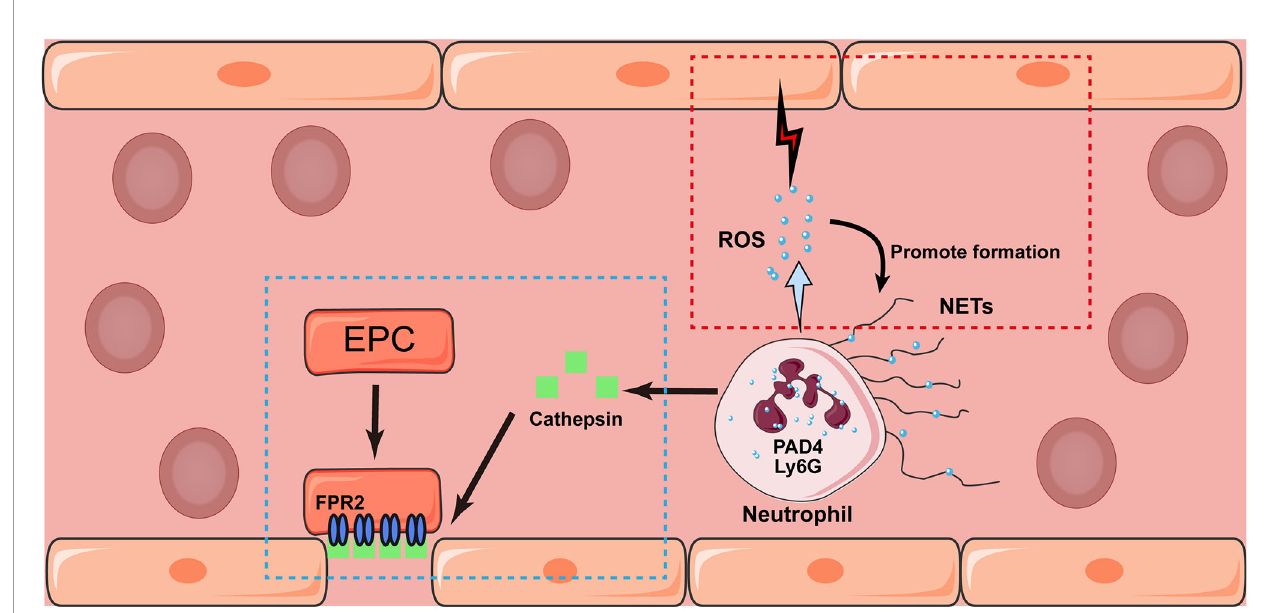
FIGURE 2 | Potential interaction between neutrophil and endothelium after stroke. Neutrophil may exhibit either detrimental (marked in red box) and bene fi cial (blue box) effects towards the endothelium after stroke. Triggered by phagocytosis, neutrophils release granular contents and formed NETs mediated by the expression of Ly6G and PAD4. In addition, the release of ROS would damage surrounding endothelium and promote the formation of NETs as well. On the contrary, the secretion of Cathepsin would induce the recruitment of circulating endothelial progenitor cell (EPC) in an N-formyl peptide receptor 2 (FPR2)-dependent manner, which promote the angiogenesis in the latter stage of